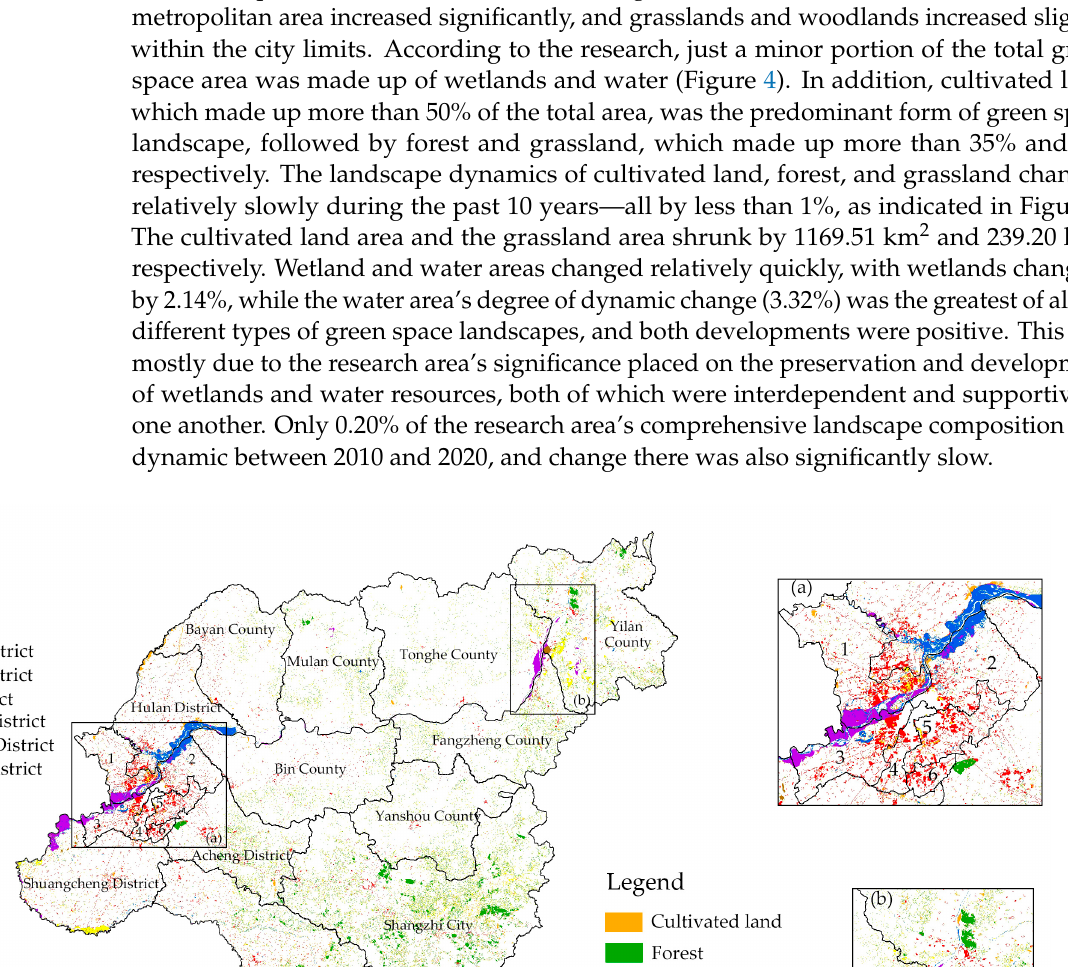
Figure 4. The proportion of green space coverage in 2010 and 2020.